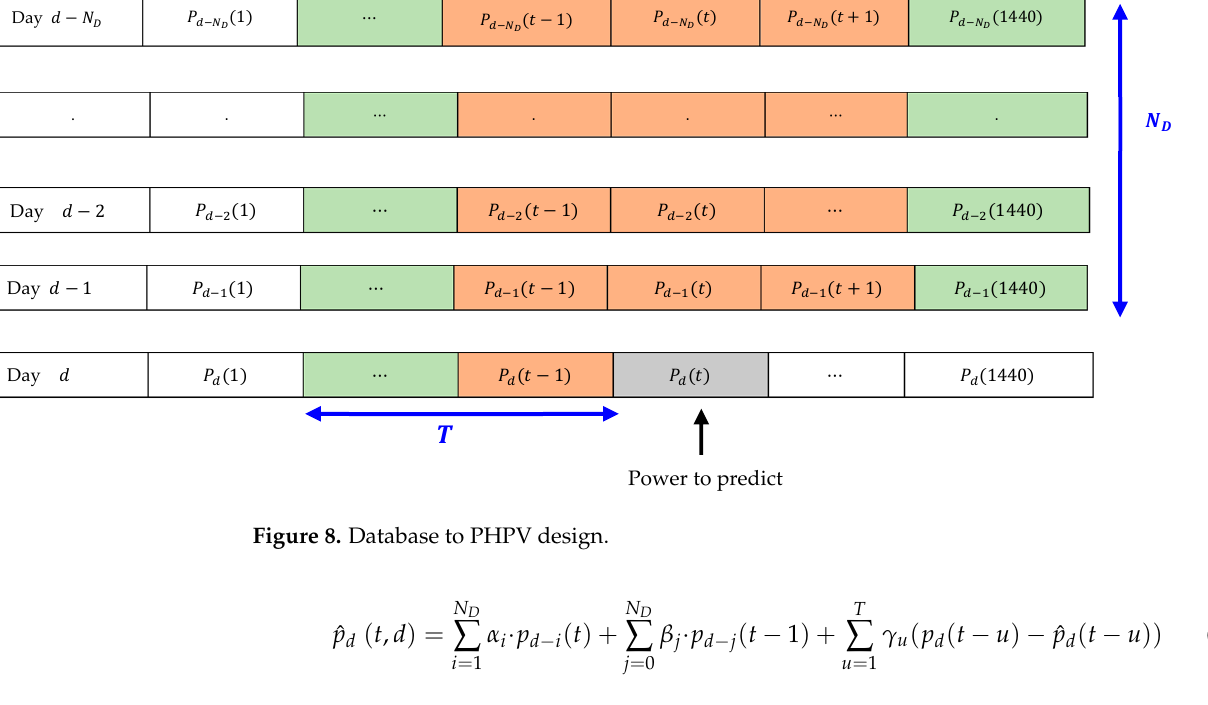
Figure 8. Database to PHPV design.